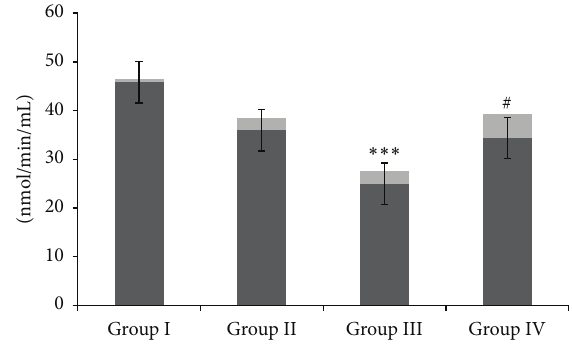
Figure 3: Effect of camel milk and gentamicin on GST enzymes. Effect of CM treatment on GM induced renal GST activity. Values are expressed as mean ± SEM ( 𝑛 = 6 ). ∗∗∗ 𝑃 < 0.001 shows significant difference in group III when compared with group I. # 𝑃 < 0.05 shows significant difference in group IV when compared with group